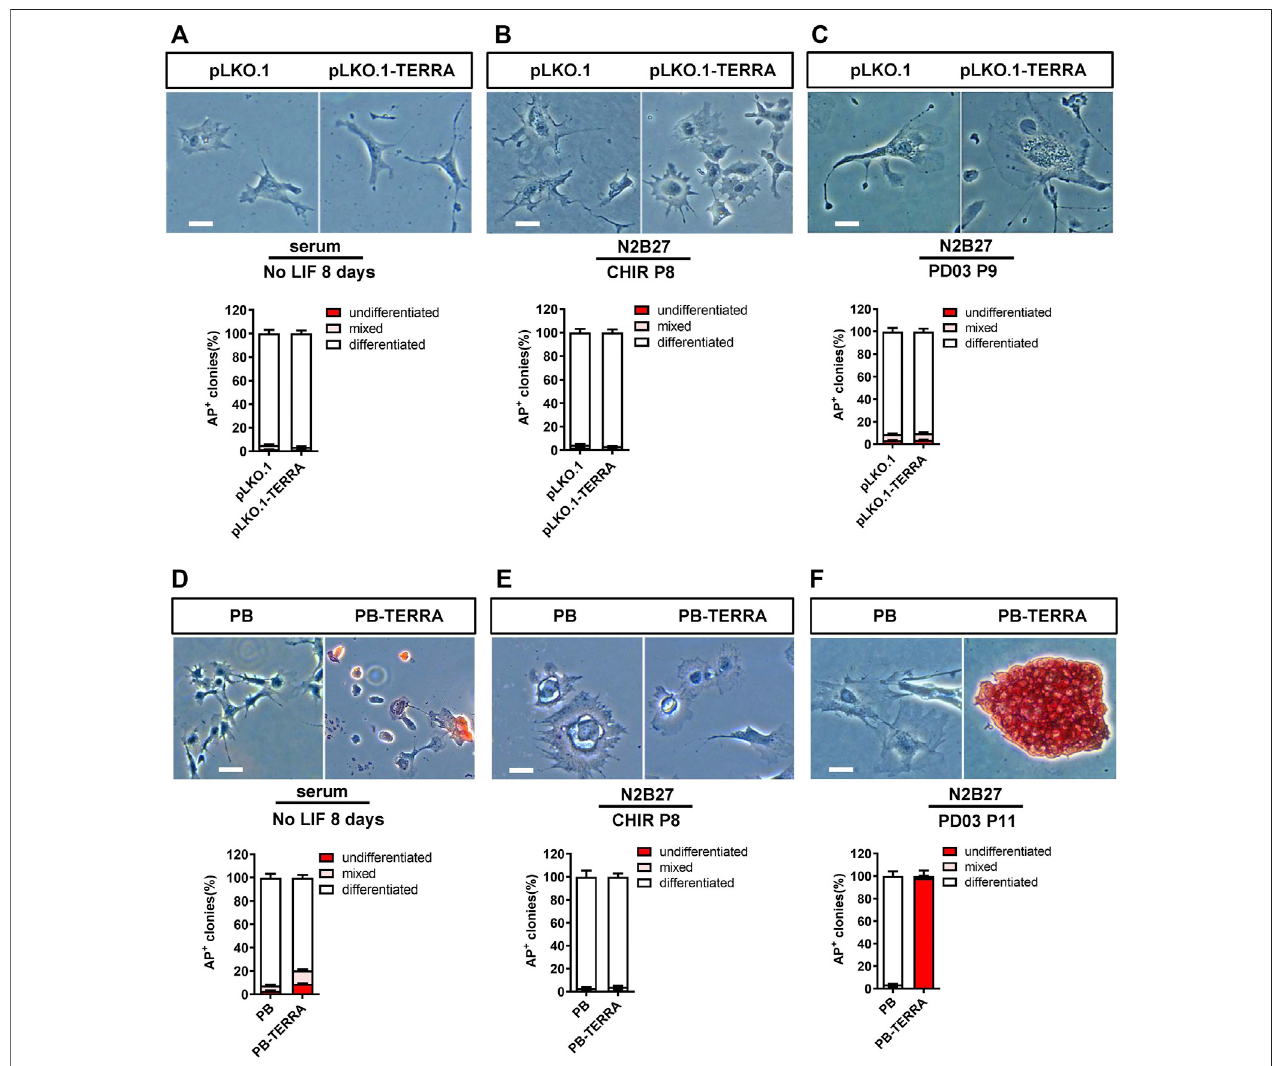
FIGURE 2 | Polyadenylated TERRA maintains mESC self-renewal in the absence of CHIR. (A – C) AP staining images and AP-positive colonies quanti fi cation of pLKO.1and pLKO.1-TERRAmESCsculturedindifferentconditions. (A) :mESCs cultured inserum withoutLIF for8days. (B) :mESCscultured inN2B27/CHIR(without PD03) medium for 8 passages. (C) : mESCs cultured in N2B27/PD03 (without CHIR) medium for 9 passages. Scale bar, 100 μ m. (D – F) AP staining images and AP- positive colonies quanti fi cation of PiggyBac (PB) and PB-TERRA mESCs cultured in different conditions. (D) : mESCs cultured in serum without LIF condition for 8 days. (E) : mESCs cultured in N2B27/CHIR (without PD03) medium for 8 passages. (F) : mESCs cultured in N2B27/PD03 (without CHIR) medium for 11 passages. Scale bar, 100 μ m.